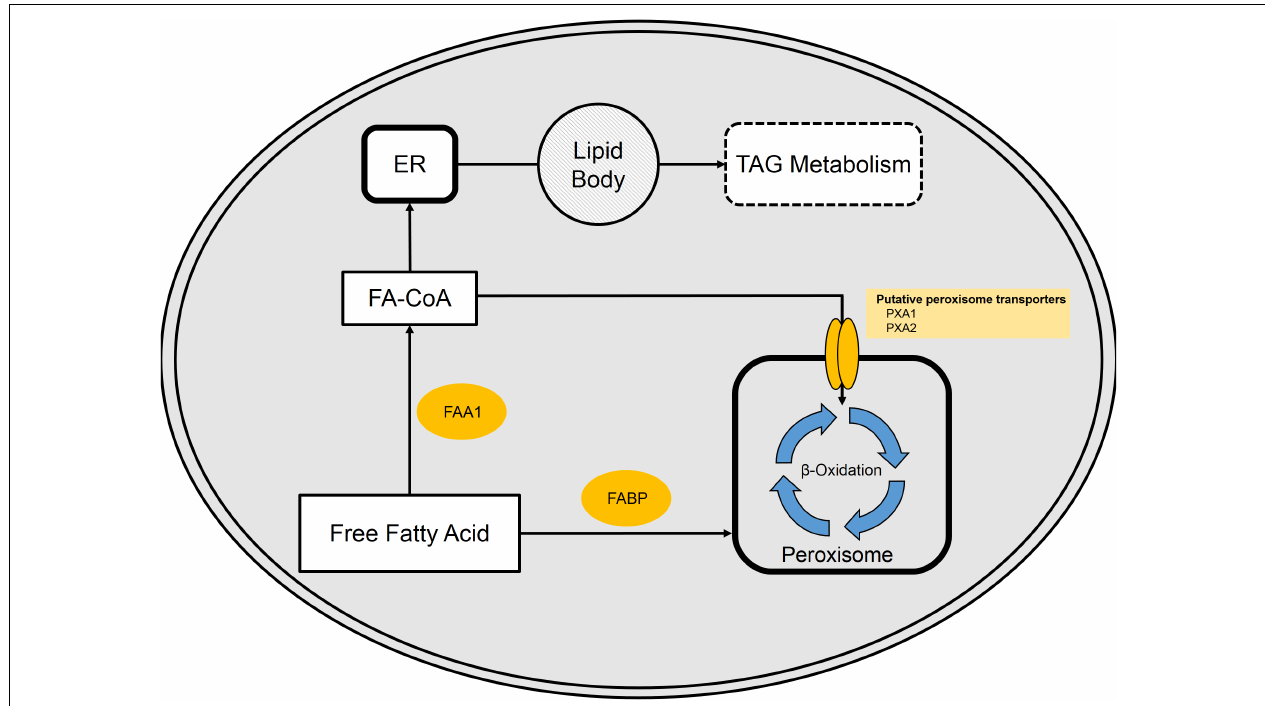
FIGURE 4 | Free fatty acid (FFA) metabolism in Y. lipolytica . FFA present in the cytosol are bound by fatty acid-binding protein (FABP). Once bound, FAs either enter the peroxisome or are activated via fatty acyl-CoA synthase (FAA1). Activated FA (fatty acyl-CoAs) is either funneled into the peroxisome or enter the TAG synthesis